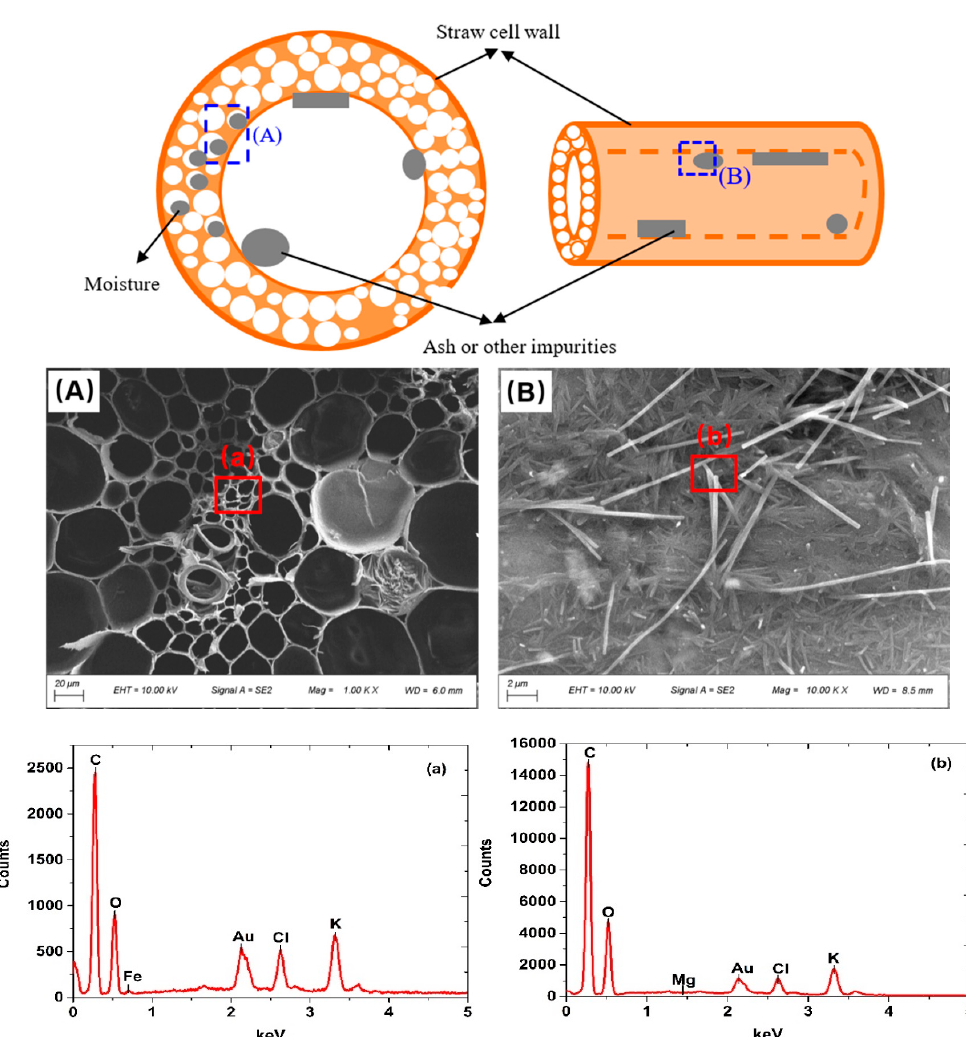
Figure 8. Schematic diagram and SEM / EDS photos of a single straw unit: cross-section ( A ) and straw cell wall ( B ). ( a ) elements tested from part ( A ), ( b ) elements tested from part ( B ).